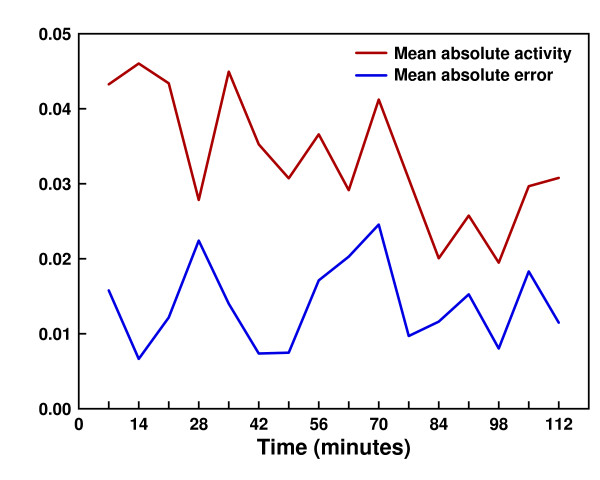
Model residuals. Shown is a comparison of the α-coefficients of transcription factors estimated using regression and displayed in Additional file 3 to those predicted by our dynamical model. We plot the mean absolute value of the α-coefficients across two periods of the cell cycle versus the mean absolute value of the residuals (i.e., the difference between the measured and predicted α-coefficients). Each time step represents a 7-minute interval. We see that the model has significant predictive power, although this diminishes as the cell cycle progresses. This may be due in part to gradual loss of synchrony over time in the experimental yeast cells from which expression was measured.